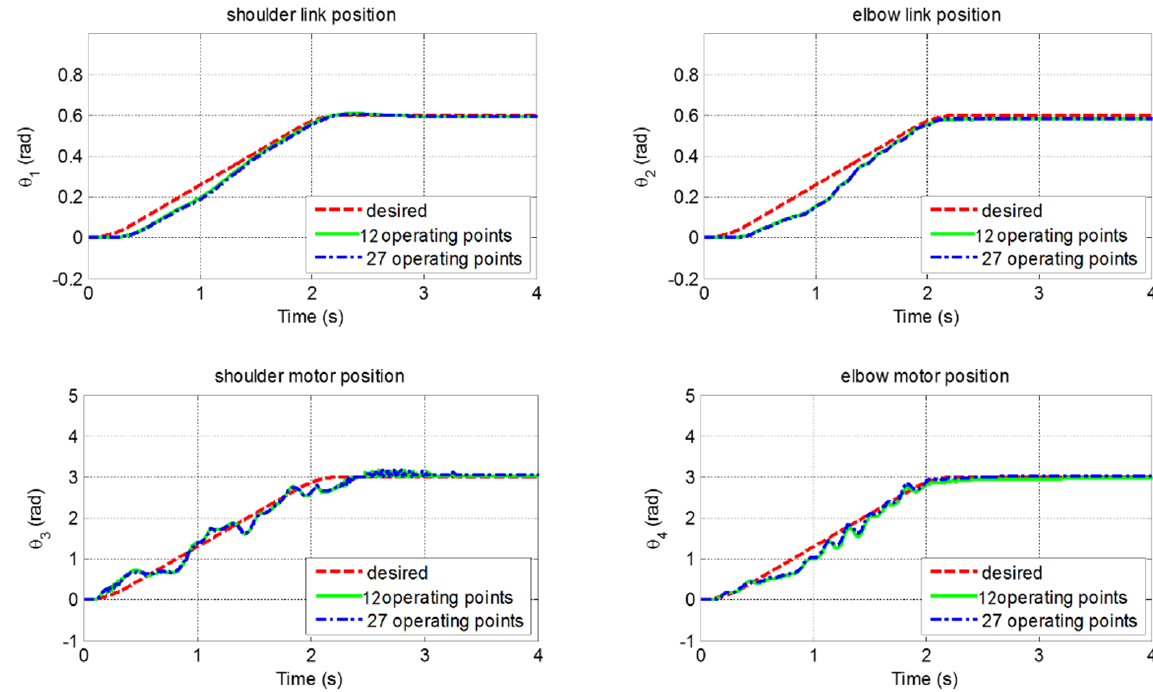
Figure 7. Experimental results of the fuzzy optimal controllers for the flexible robot.